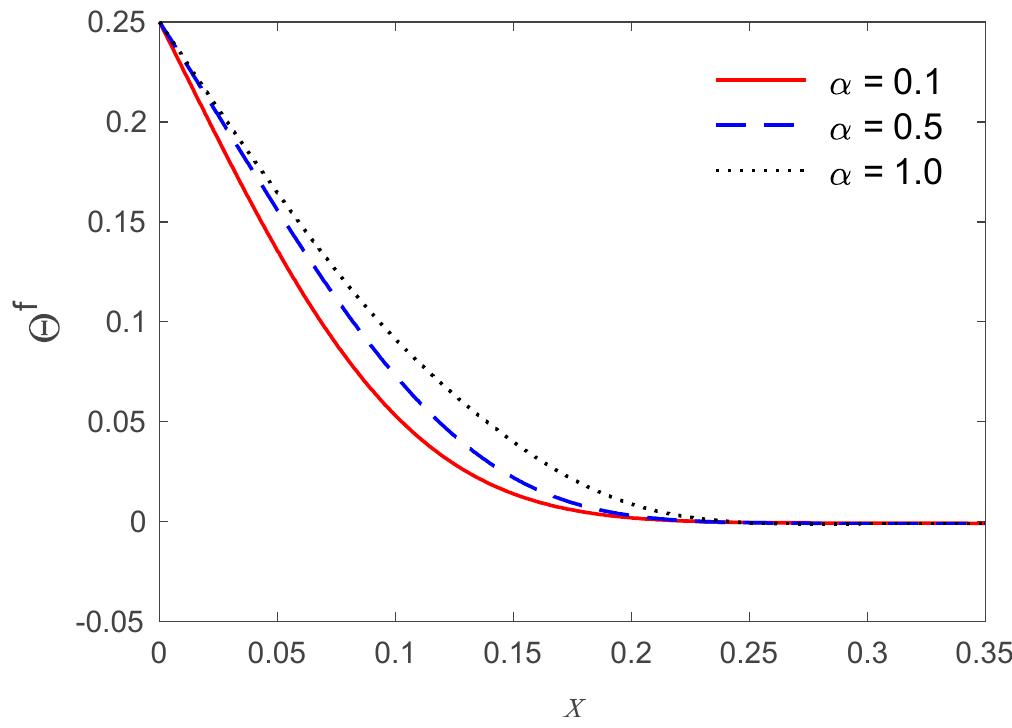
Figure 1. The variations of fluid temperature Θ f via x for three values of fractional parameter.